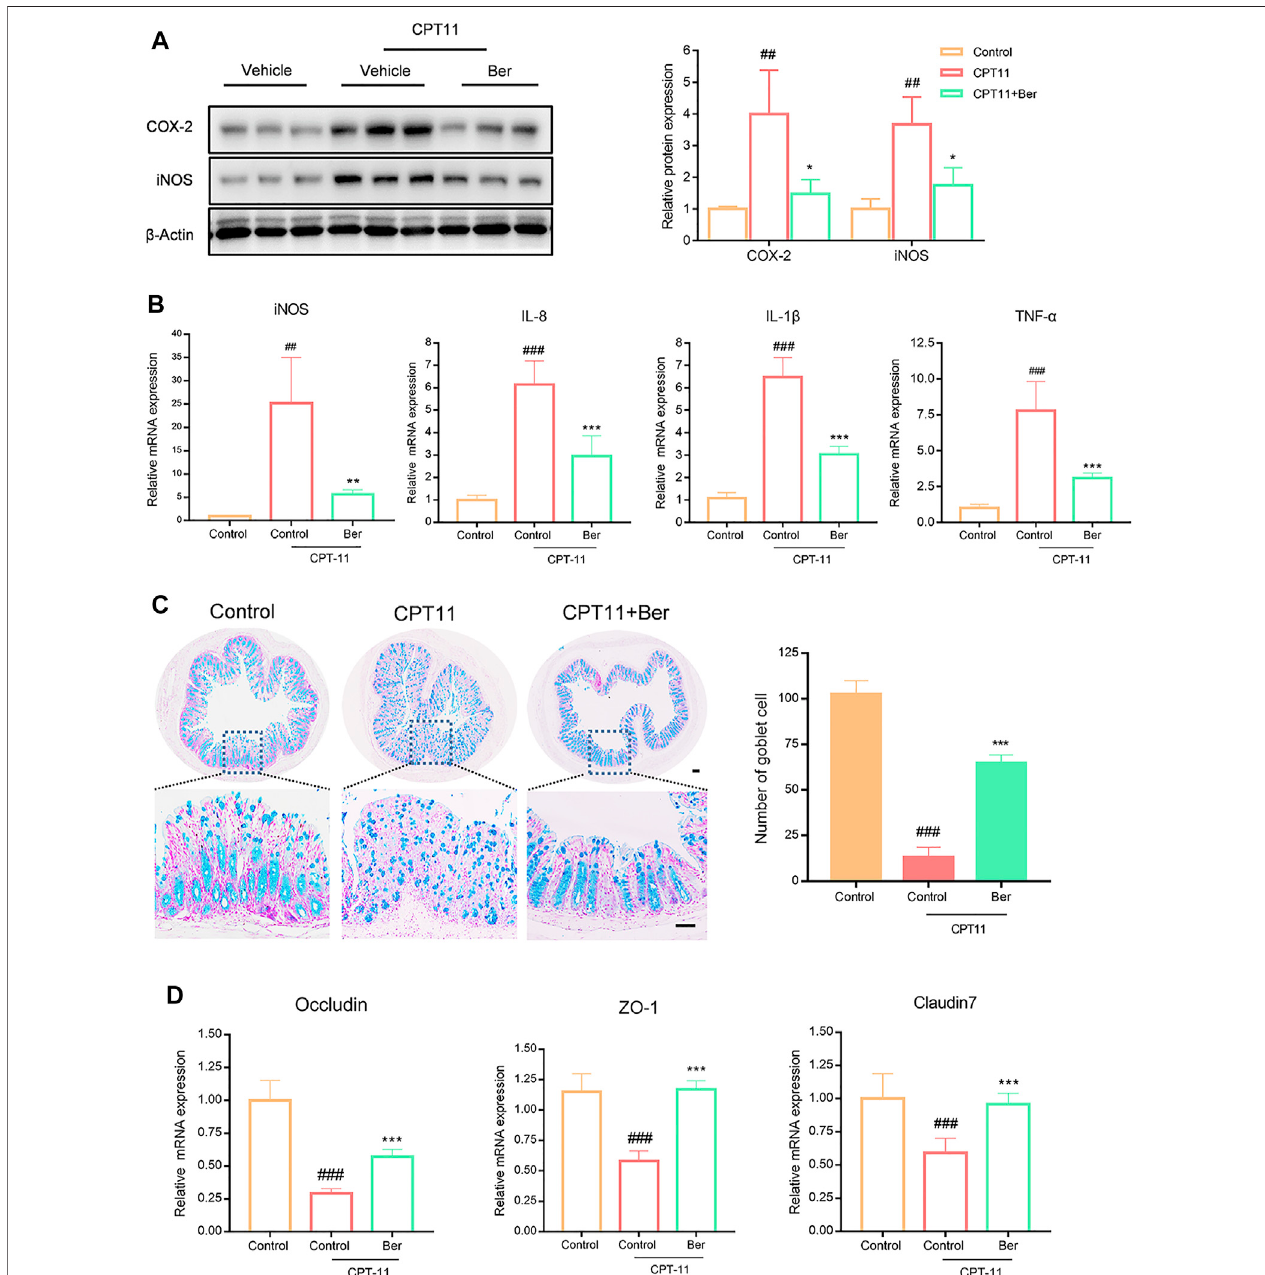
FIGURE 2 | Berberine inhibited the expression levels of pro-in fl ammatory mediators and promoted the mRNA expression levels of tight junction protein in vivo . (A) The effect of berberine on the expression of pro-in fl ammatory mediators (COX-2 and iNOS) in colonic tissues. Representative western blots and quantitative analysis of COX-2andiNOS proteins. (B) mRNAexpression levelsofiNOS,IL-8,IL-1 β ,andTNF- α incolontissue,asdetermined byqRT-PCR. (C) RepresentativeAlcianblue(AB)/ (Periodic Acid-Schiff stain) PAS-stained colonic tissue sections (Scale bars, 100 μ m) and goblet cell number. (D) mRNA expression levels of Occludin, ZO-1, and Claudin-7, in colon tissue, asdetermined by qRT-PCR. All mRNA expression levels were normalized to β -Actin. Data are expressed as the mean ± SD ( n (cid:2) 3 per group). ## p < 0.01, ### p < 0.001 vs. the control group; * p < 0.05, ** p < 0.01, *** p < 0.001 vs. CPT11 + berberine treated group.